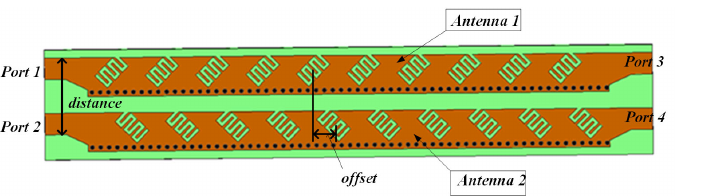
Figure 9. The structure of the two interdigital slot antennas; an offset is added to enhance the axial ratio of the CP generated.